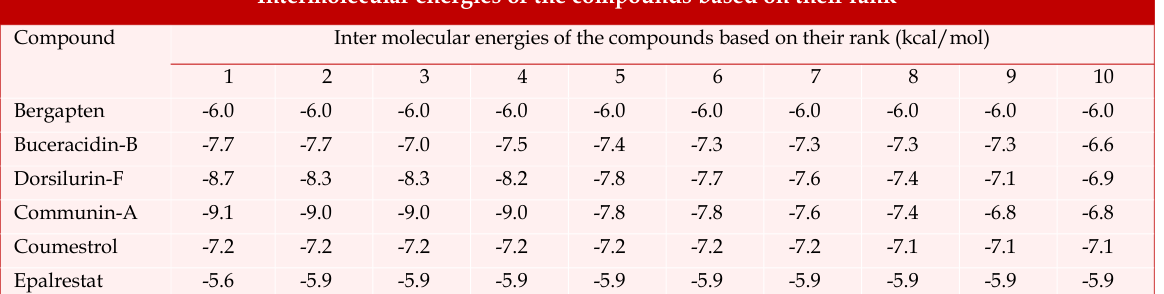
Intermolecular energies of the compounds based on their rank Compound Inter molecular energies of the compounds based on their rank